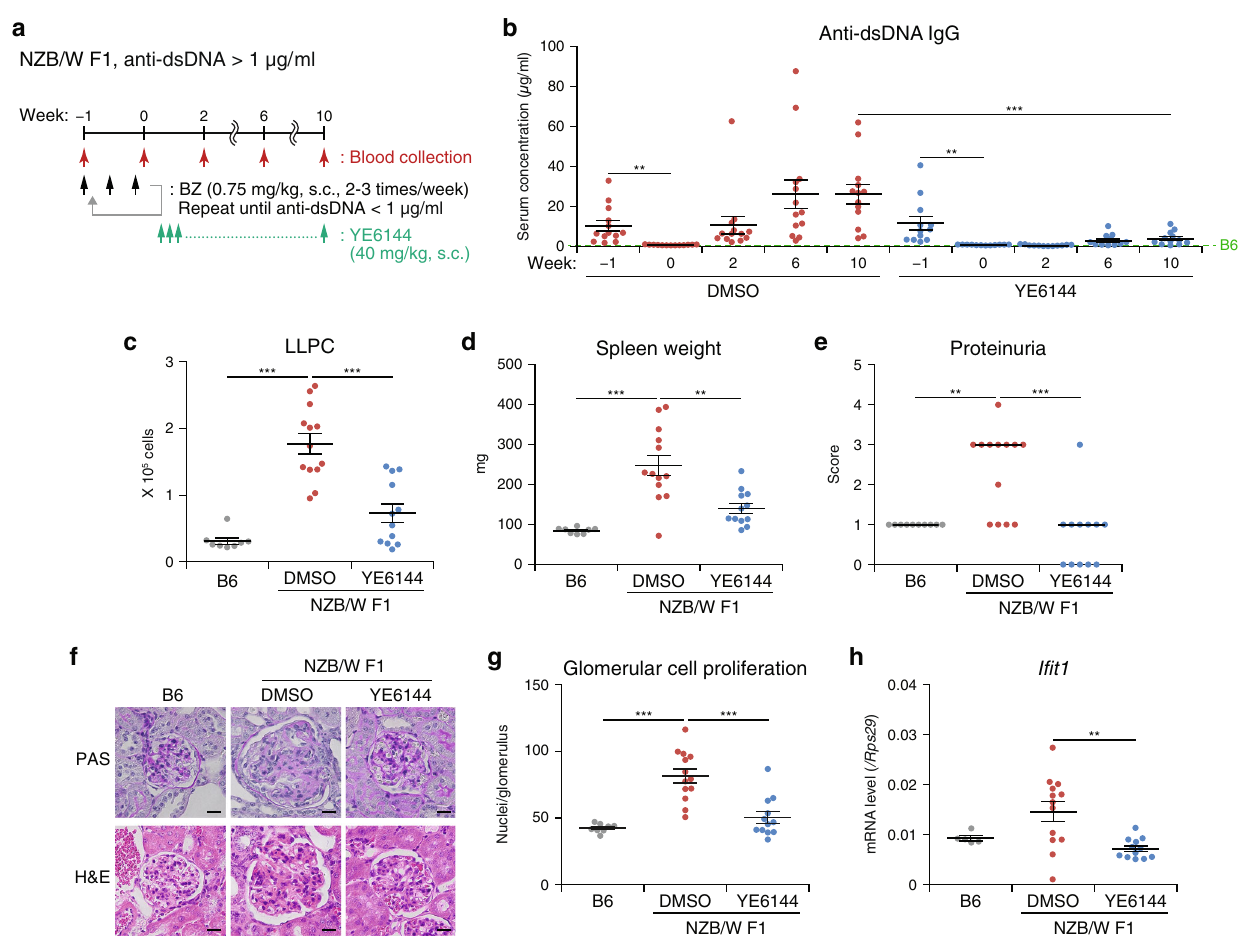
Fig. 6 Maintenance of remission by YE6144 in the NZB/W F1 mouse model of SLE. a The scheme of YE6144 treatment combined with BZ administration b Autoantibody production. Serum anti-dsDNA IgG levels in NZB/W F1 female mice (31 – 34 weeks of age at week 0) treated with either DMSO ( n = 13) or YE6144 ( n = 12) after BZ injection were analyzed by ELISA. The dashed line denotes the mean data from untreated WT C57BL/6 (B6) mice ( n = 3). c The LLPC number in the spleen from WT B6 mice ( n = 8) and NZB/W F1 mice in b at 10 weeks after the initial YE6144 injection (age 41 – 44 weeks) was analyzed by fl ow cytometry. d Spleen weight of mice in c . e The proteinuria score of WT B6 mice ( n = 10) and NZB/W F1 mice in c . f , g Kidney pathology of mice in c analyzed as in Fig. 2d, e. Representative images are shown and scale bars correspond to 20 μ m ( f ). h ISG expression. The I fi t1 mRNA level in peripheral blood from WT B6 mice ( n = 5) and NZB/W F1 mice in c was analyzed by RT-qPCR. Data were compiled from three independent experiments. Horizontal bars represent mean ± SEM ( b – d , g , h ) or median ( e ). ** P < 0.01, *** P < 0.001 (two-sided paired t test in b [the same treatment samples]; two- sided Student ’ s t test in b [different treatment samples], c , d , g , h ; and two-sided Mann – Whitney U test in e